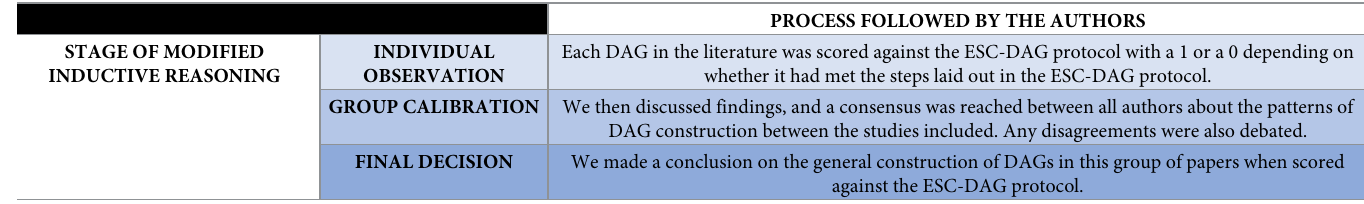
PROCESS FOLLOWED BY THE AUTHORS